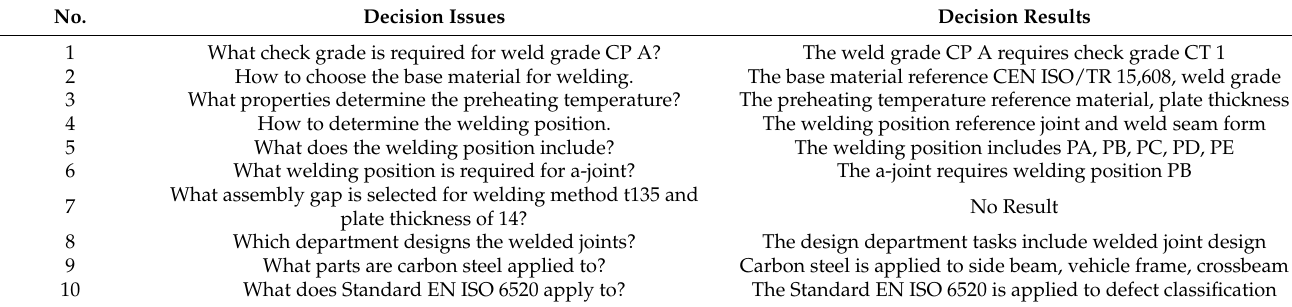
Table 5. Causal decision